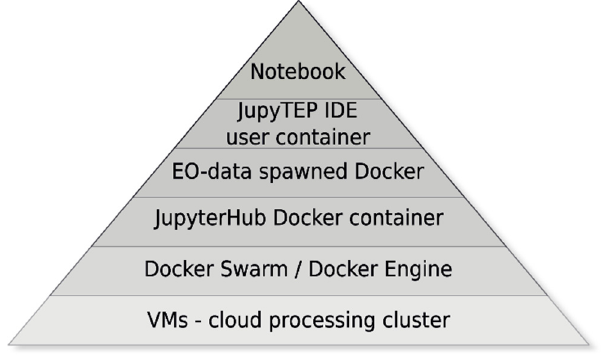
Figure 3. Diagram of JupyTEP IDE infrastructure components.